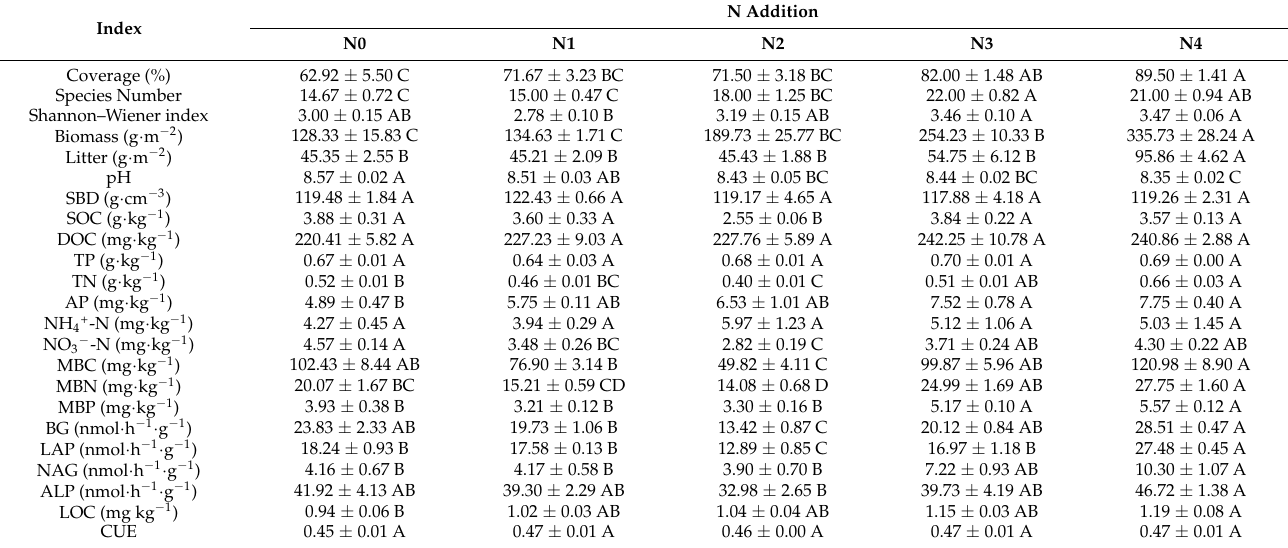
Table 1. Changes in vegetation community and whole soil’s physical and chemical properties under nitrogen